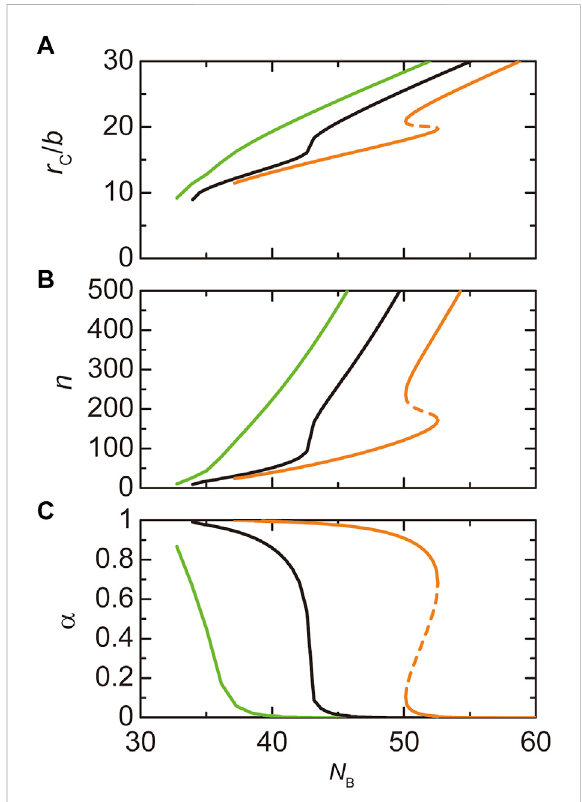
N A of units in the A